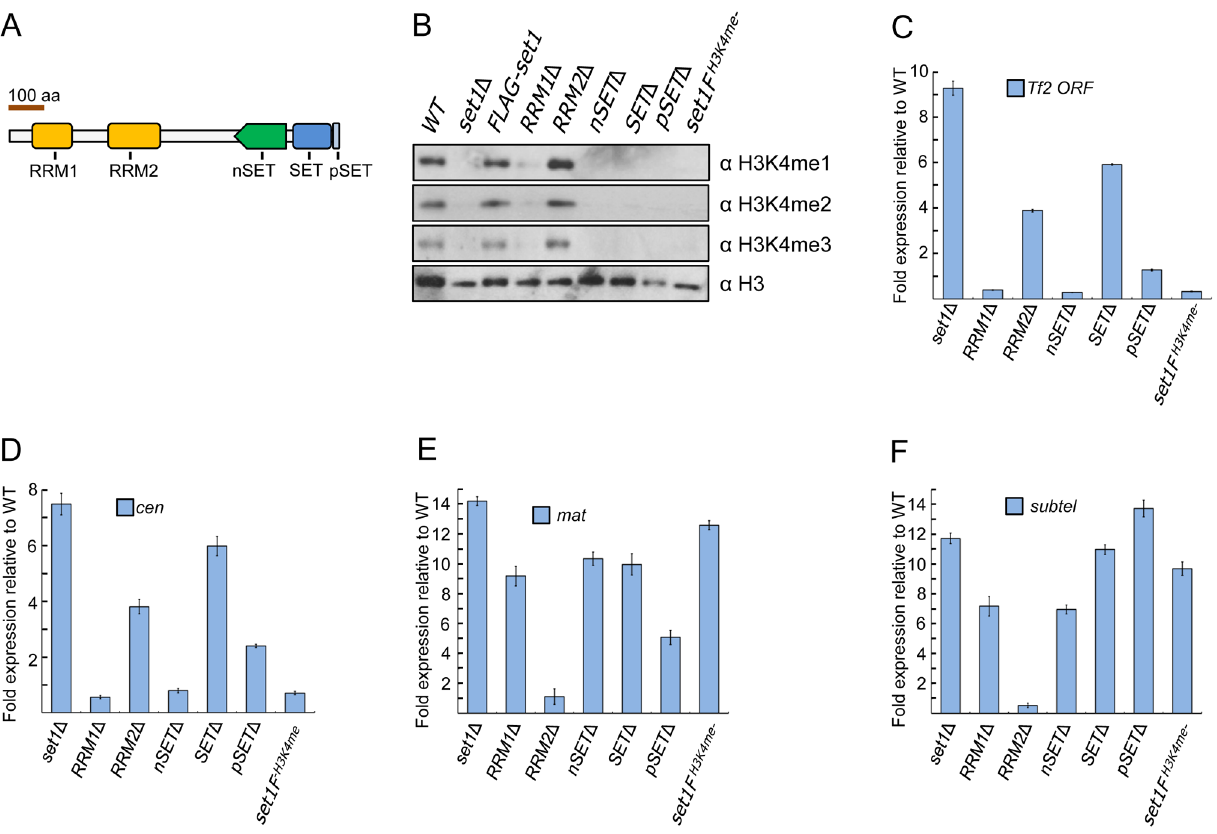
Figure 1. Set1 represses different classes of repetitive elements via distinct functional domains. (A) Schematic of S. pombe Set1 protein domain architecture. (B) H3K4 methylation (H3K4me) in set1 domain mutants. Mono (H3K4me1), di (H3K4me2), and tri (H3K4me3) methylation of H3K4 was analyzed from histone extracts of indicated set1 mutant strains by western blotting. Full-length FLAG-set1 and the indicated deleted domain mutants of set1 contain an N-terminal FLAG (3 6 ) epitope. set1F H3K4me- denotes an H3K4me null mutant due to the presence of a FLAG (3 6 ) epitope at the C-terminus of set1 . (C) Tf2 repression requires intact RRM2 and SET domains. (D–F) Set1 represses heterochromatic loci dependent and independent of H3K4me. Expression of Tf2 ORF and heterochromatic loci was analyzed by qRT-PCR. Fold changes relative to wildtype were normalized by act1 expression. (s.d., error bars; n =3). Pericentromeric repeat dg ( cen ), silent mating type cenH ( mat ), subtelomeric prl70 ( subtel ).